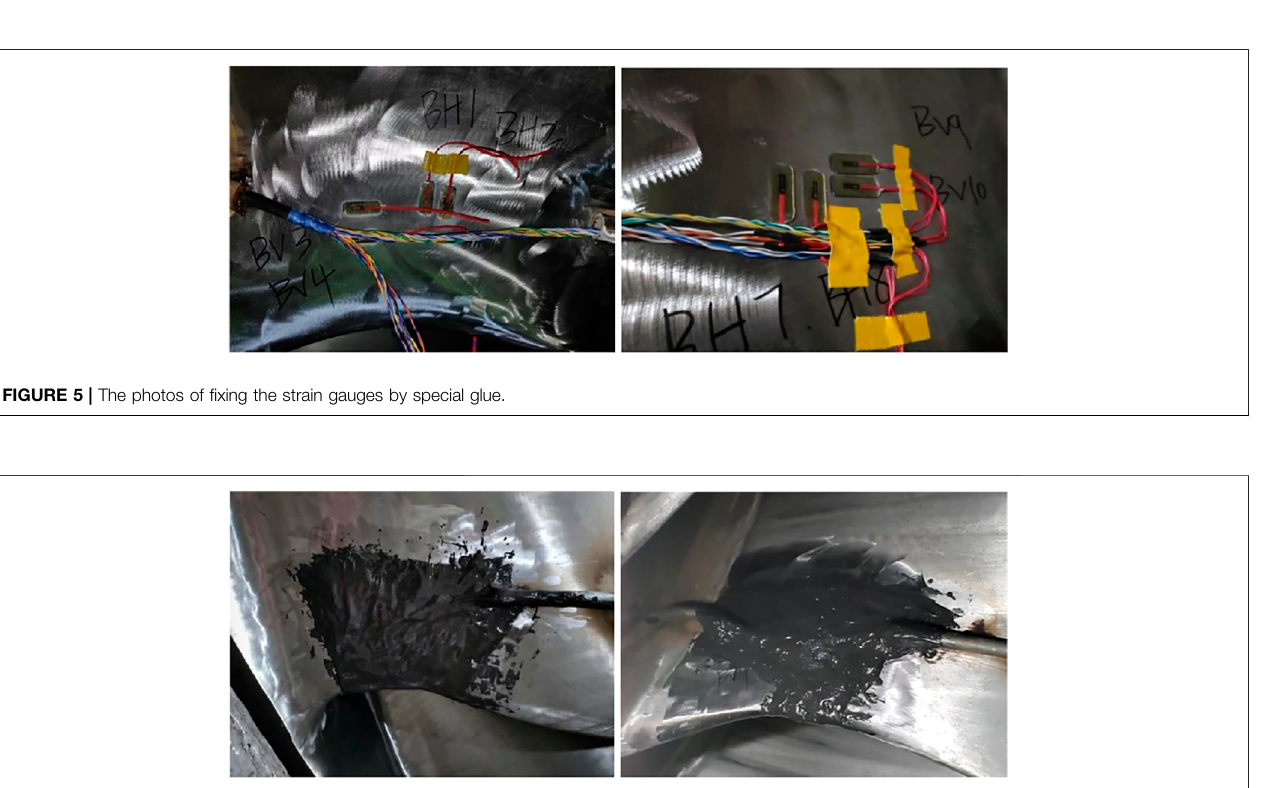
FIGURE 6 | The photos of protection of the strain gauges by metal protective